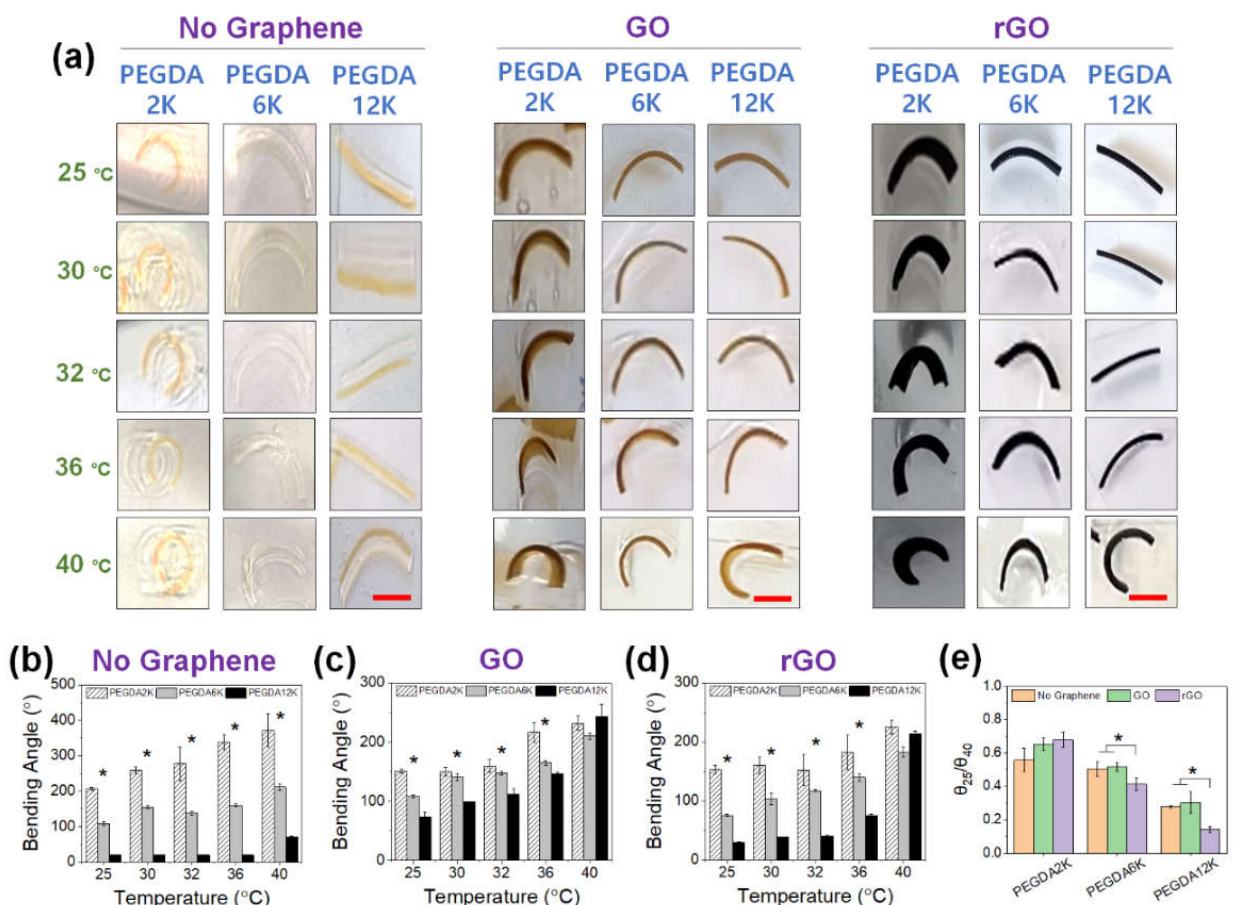
Figure 7. ( a ) Photographs of GO or rGO-laden PEG-PNIPAm hydrogel actuators at various temper- atures from 25 °C to 40 °C (scale bar: 5 mm). The concentration of GO or rGO was 0.2%. For PEG- PNIPAm hydrogels without graphene, orange dye was added for better visualization ( b – d ) The bending angles were quantified from the images in ( b ) (* p < 0.05 compared between different M W ’s of PEGDA, n = 10). (e ) The ratios of bending angles measured at 25 °C (θ 25 ) and 40 °C (θ 40 ).